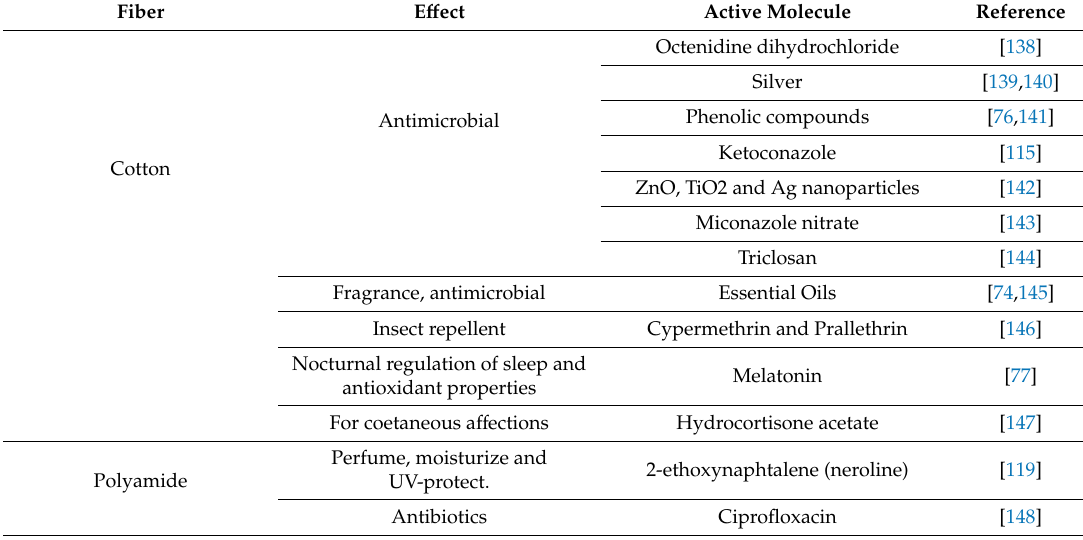
Table 3. Studies that used cyclodextrin to graft finishes in